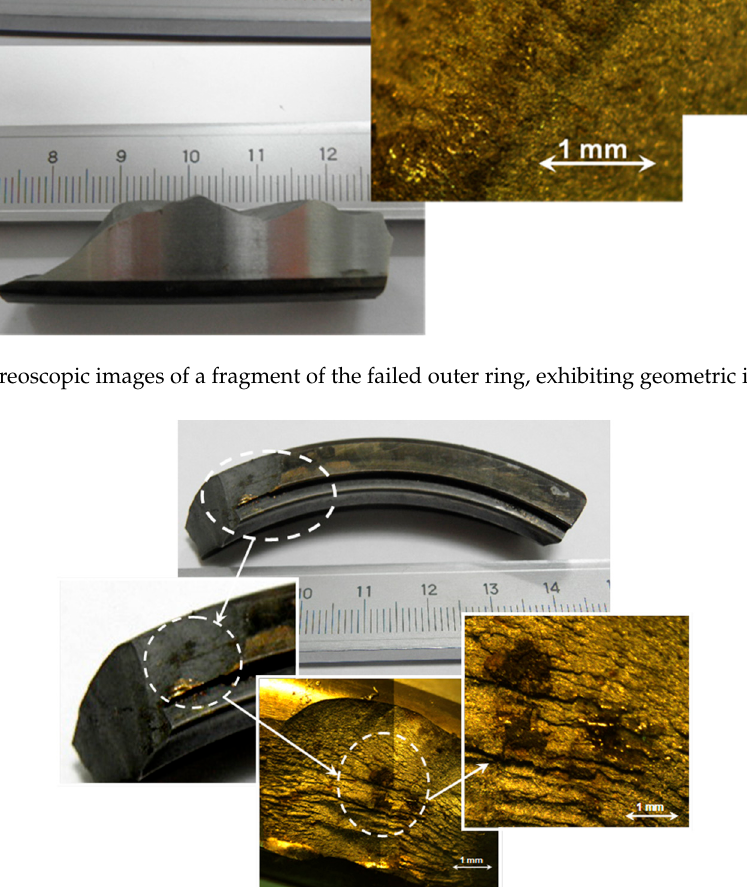
Figure 5. Stereoscopic images of a fragment of the failed outer ring, exhibiting signs of oxidation on the fracture surface.